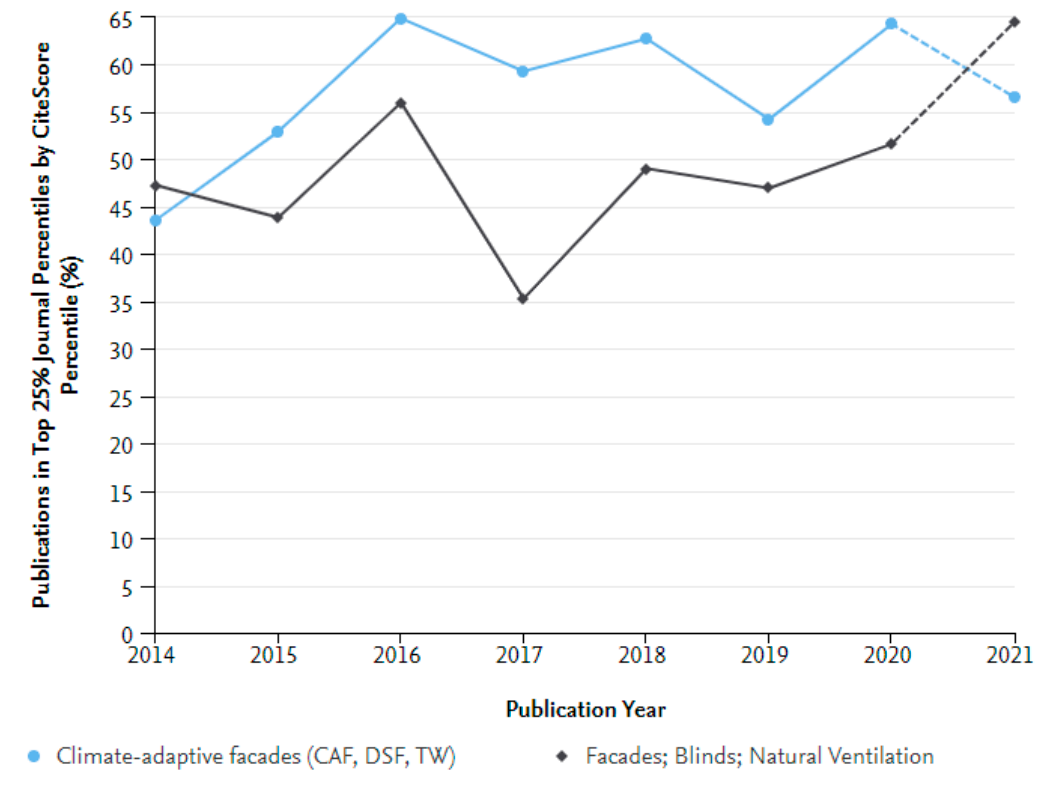
Figure 28. Benchmarking the Publication Year and Publications in Top 25% Journal Percentiles by CiteScore Percentile (%) (accessed on 21 January 2022).